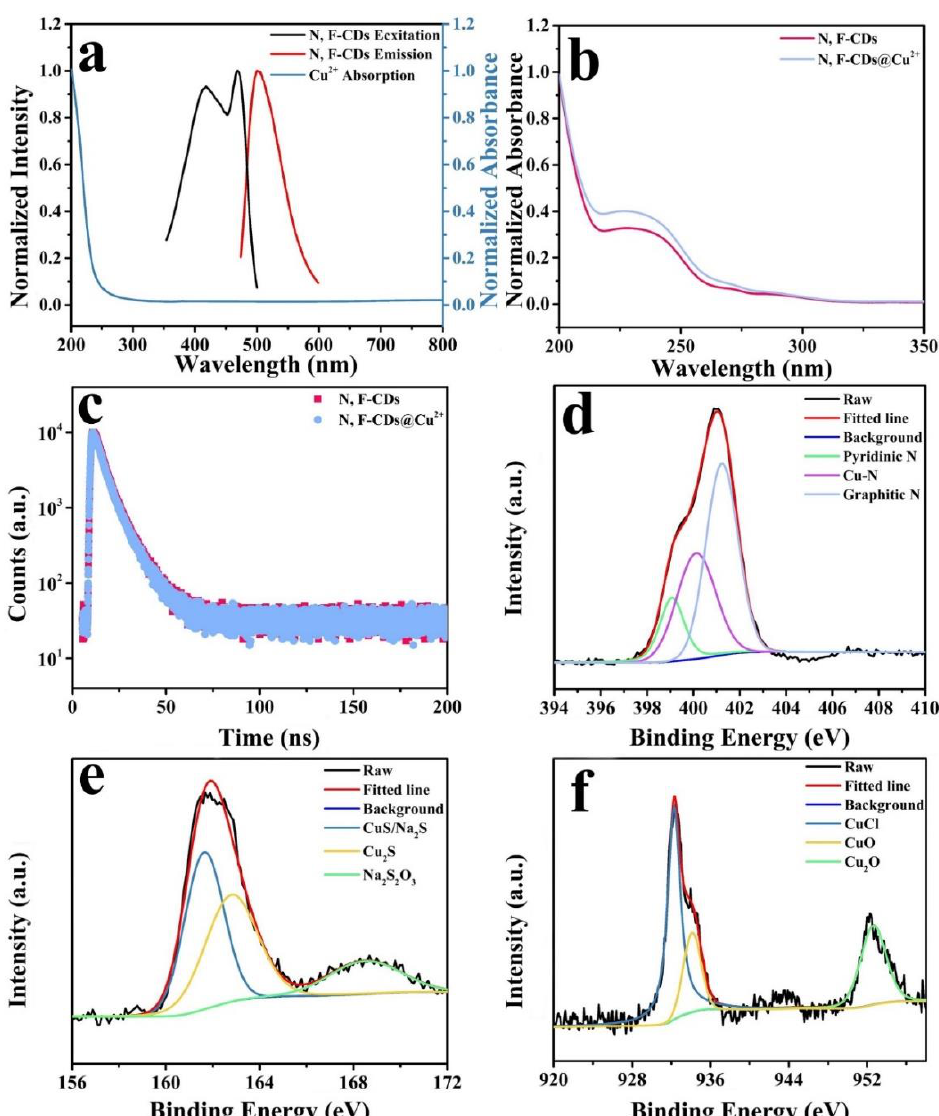
Figure 7. ( a ) UV absorption of Cu 2+ (blue line), excitation (black line), and emission (red line) spectra of the N, F-CDs. ( b ) UV absorption of the N, F-CDs and N, F-CDs@Cu 2+ . ( c ) Spectra of the fluorescence lifetime decay of the N, F-CDs and N, F-CDs@Cu 2+ . ( d ) High-resolution N1s XPS profiles of the N, F-CDs@Cu 2+ . ( e ) High-resolution Cu1s XPS profiles of the N, F-CDs@Cu 2+ . ( f ) High-resolution S1s XPS profiles of the N, F-CDs@Cu 2+ + S 2 −